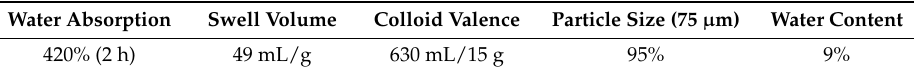
Table 2. Main characteristics and properties of bentonite and